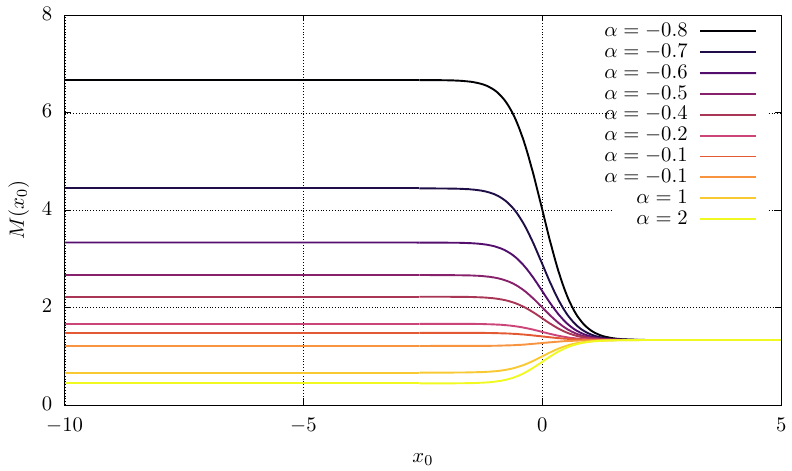
Figure 5 . Metric on the moduli space in the (cid:30) 4 BPS-impurity model with non-localized, step function impurity (5.4) for di(cid:11)erent values of the impurity strength (cid:11)